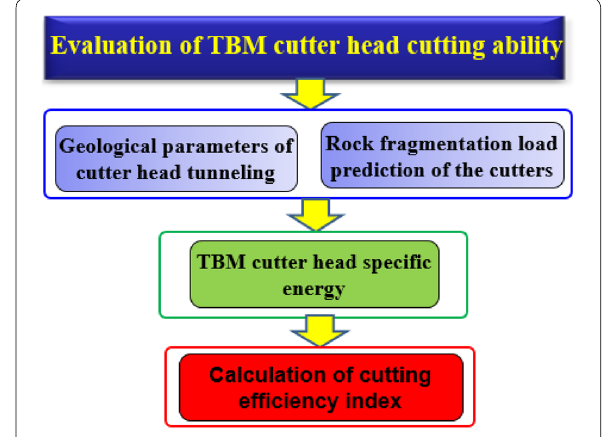
Figure 3 Flow diagram of cutting